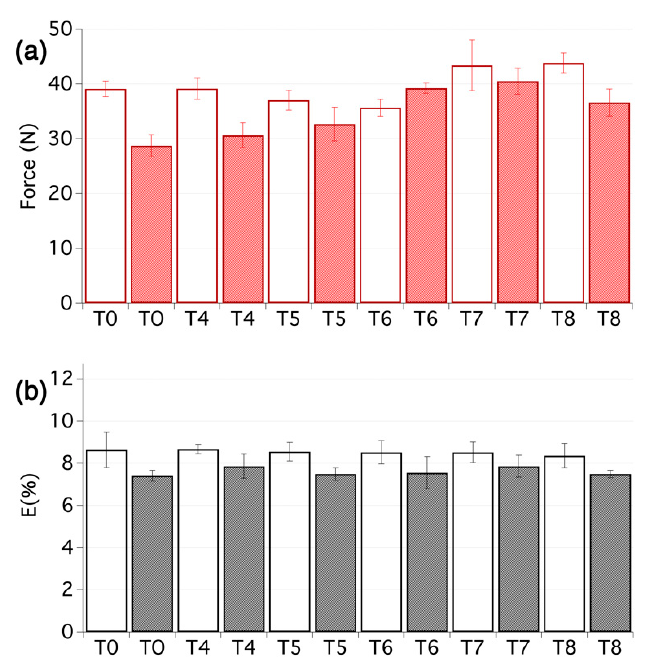
Figure 5. ( a ) Maximum force and ( b ) elongation at break for the second set of samples before ageing (empty bars) and after ageing (filled bars). From 5 to 10 tensile measurements per sample were carried out.